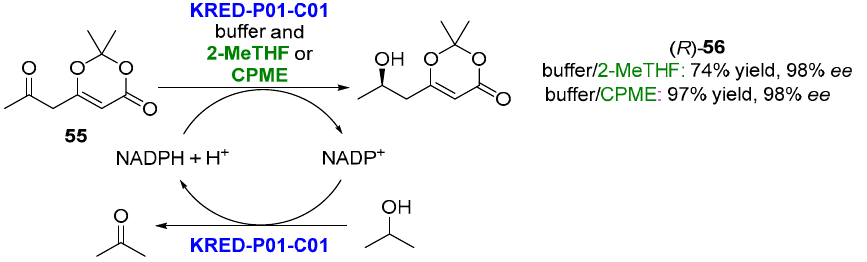
Figure 29. KRED-catalyzed reduction of β -ketodioxinones ( 55 ) in biphasic